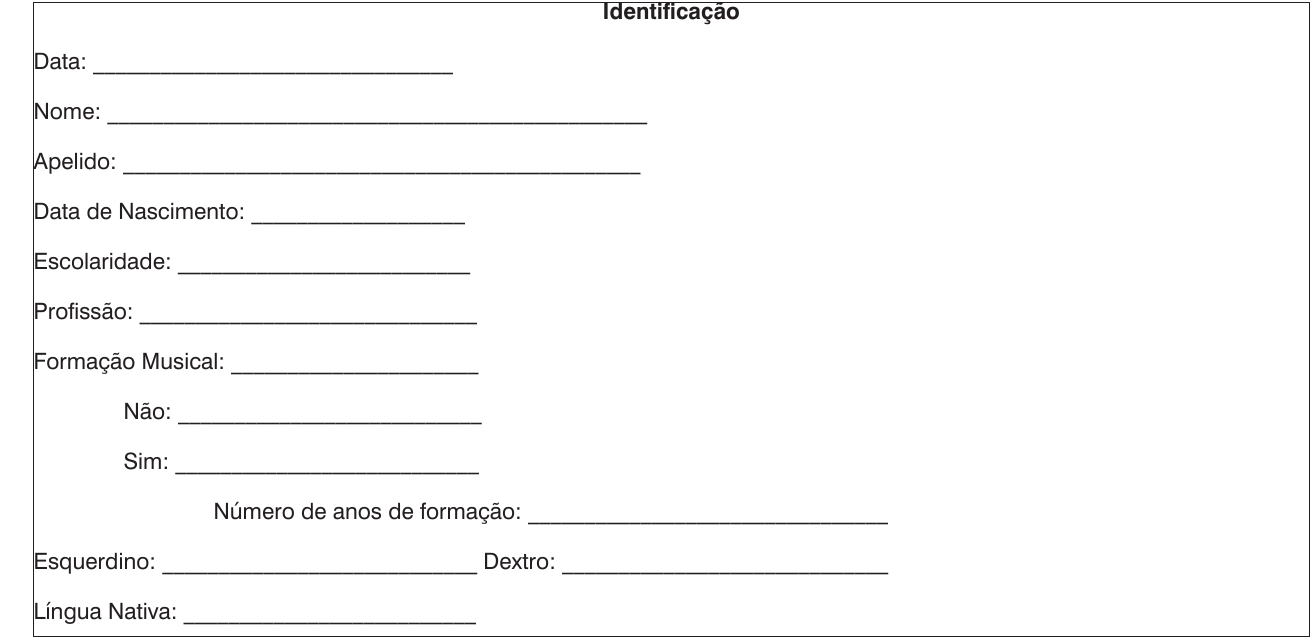
Figura 3. Folha de identificação do sujeito